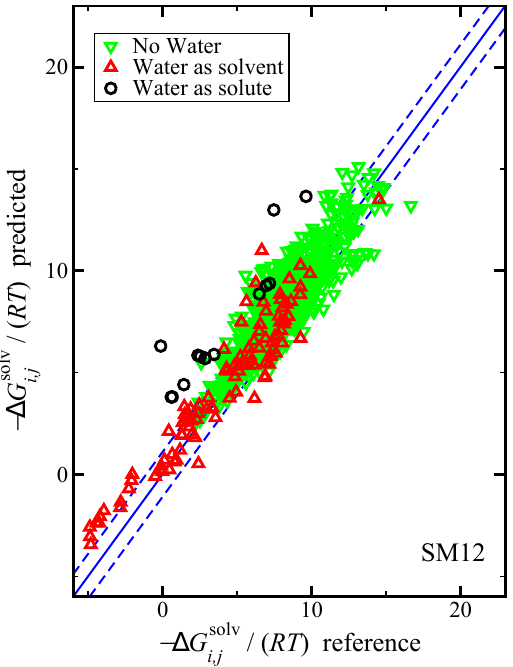
Figure 3. Parity plot of the predicted versus reference values of − ∆ G solv universal solvent model for the case where water was the solvent, water was the solute, and where water was neither the solvent or solute, as indicated. The blue lines corresponds to the y = x line, and the dashed blue lines correspond to ± 1.1 and are drawn as a reference; the value of 1.1 was used based on the RMSE for the SM12 predictions. The reference values are from the Minnesota Solvation